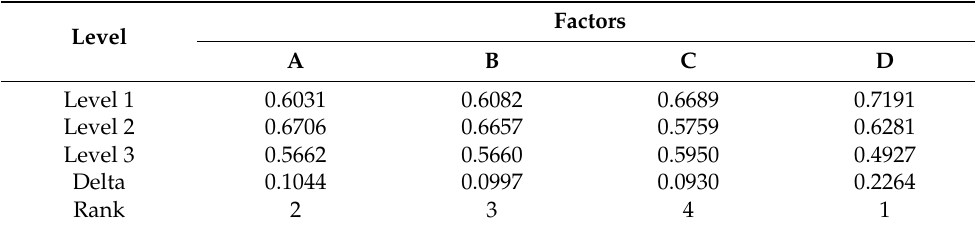
Table 10. Response table of